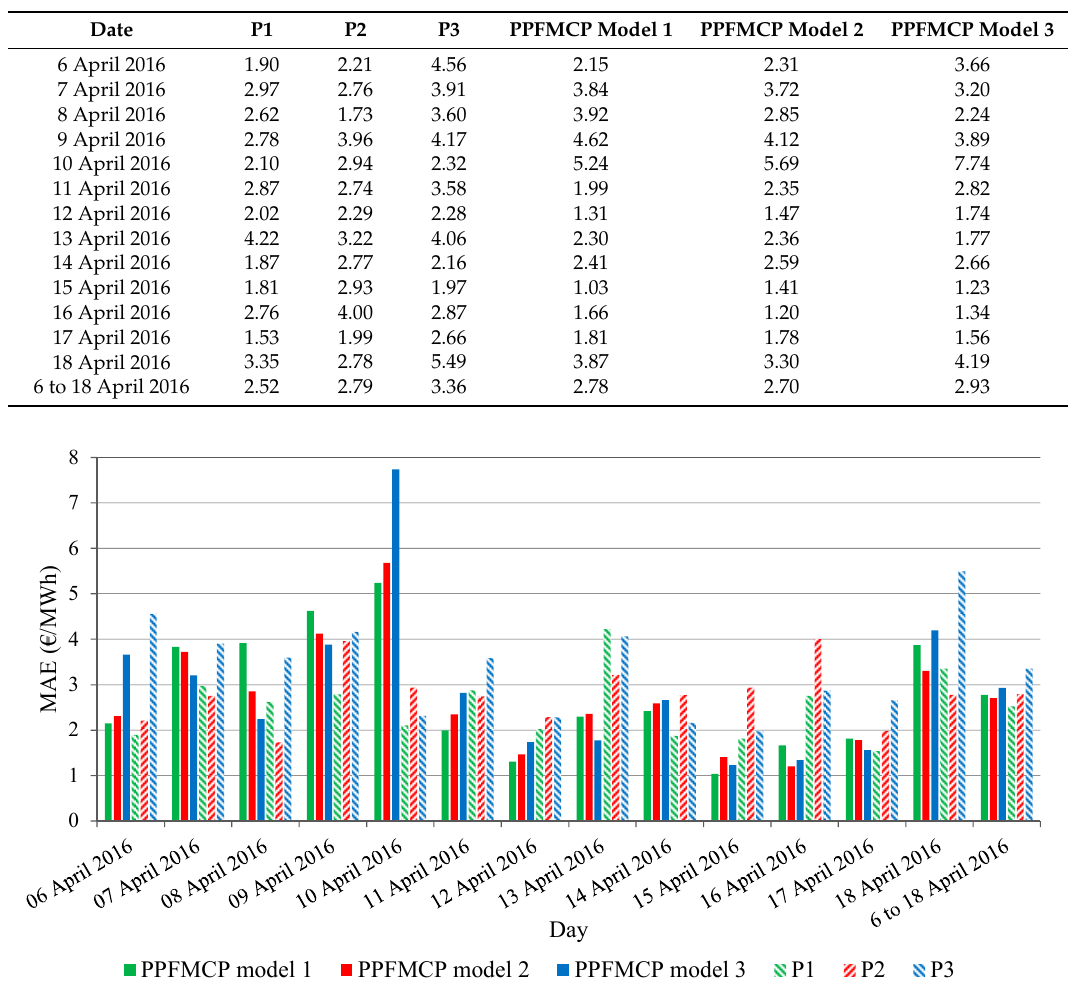
Figure 11. Mean absolute error values of point forecast of PPFMCP models and of the three best predictors.